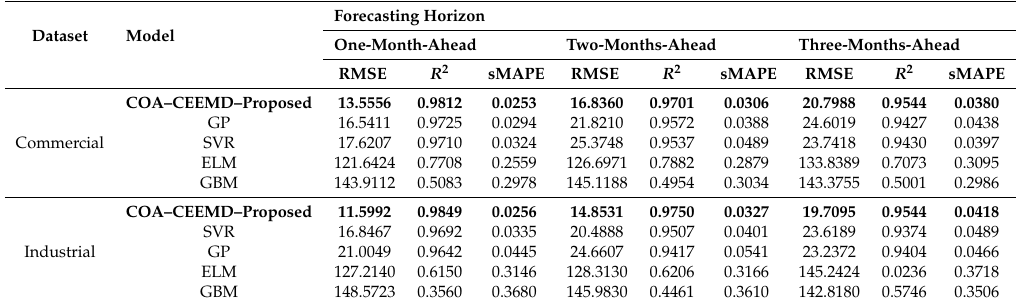
Table 6. Performance measures of proposed and compared models used to forecasting Brazilian electricity price with multi-step-ahead Forecasting Horizon Dataset Model One-Month-Ahead